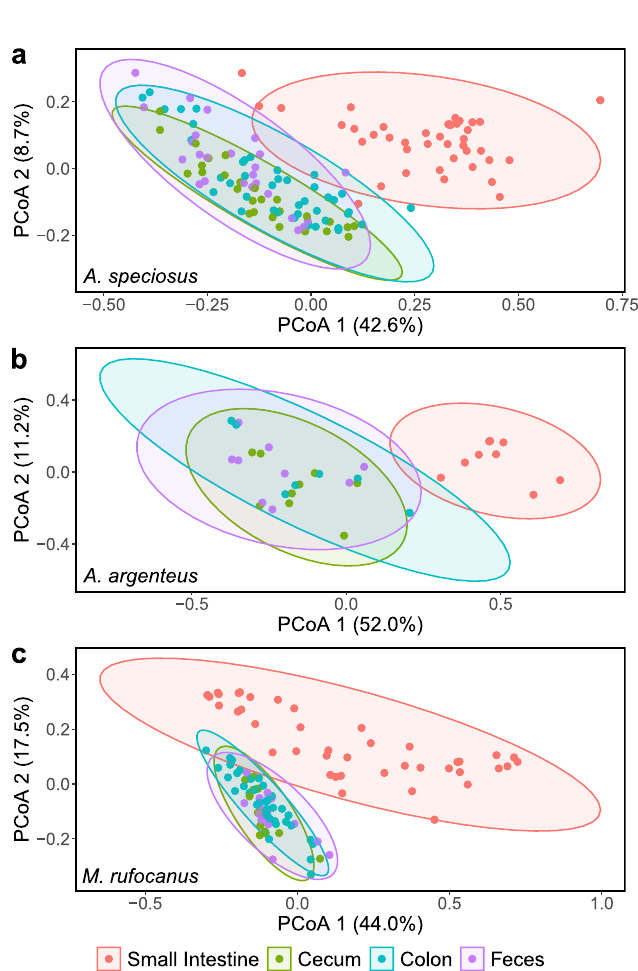
Figure 3. PCoA plots showing among gut region variation of the gut microbiome within ( a ) A. speciosus , ( b ) A. argenteus , and ( c ) M. rufocanus based on weighted UniFrac. Ellipses indicate 95% confidence interval and the percentages in parenthesis are the proportion of variation explained by the PCoA